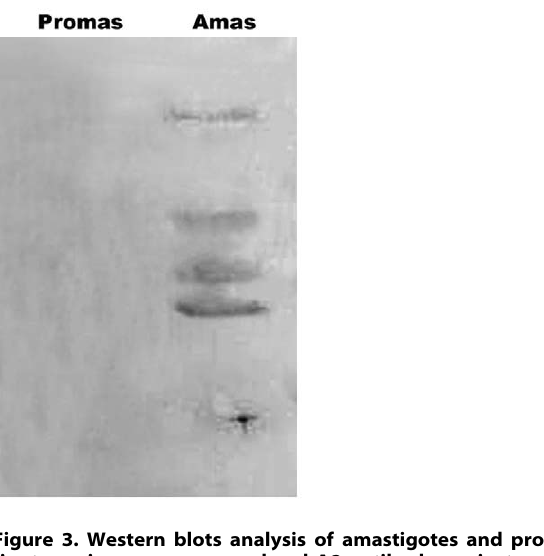
Figure 3. Western blots analysis of amastigotes and promas- tigotes using mouse monoclonal A2 antibody against amasti-